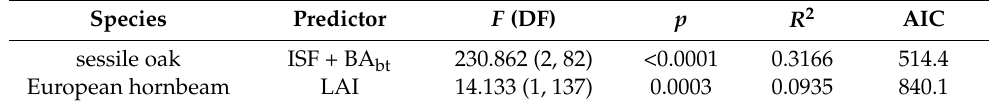
Table 7. The goodness of fit characteristics of the new sprouts height models.